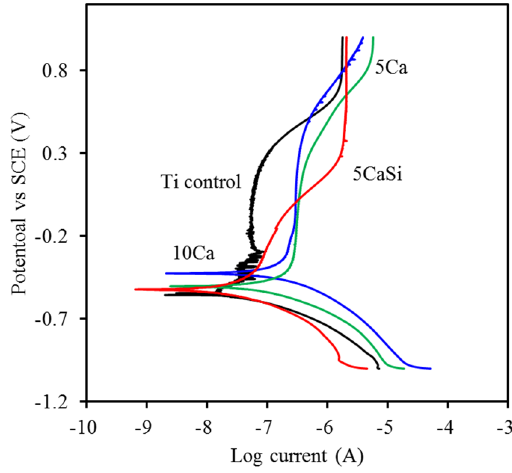
Figure 7. Typical potentiodynamic polarization curves of all samples in simulated body fluid (SBF).